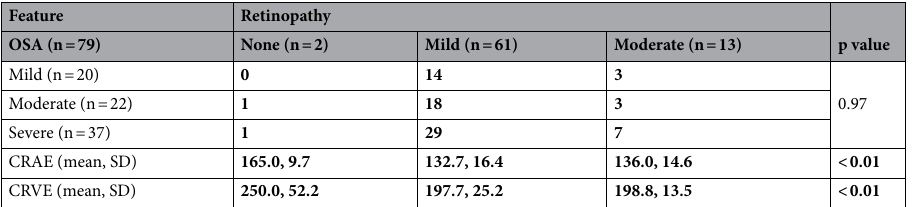
Retinal arteriole calibre